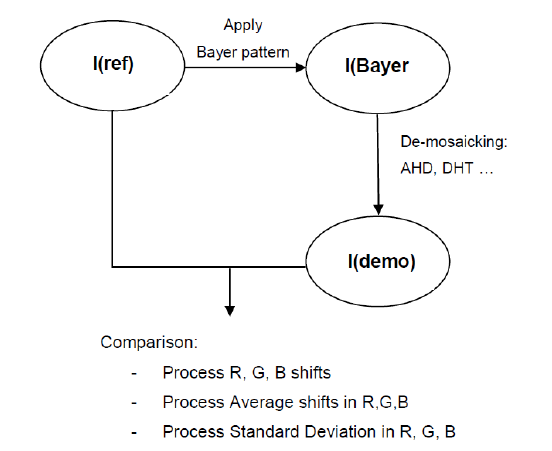
Figure 2: De-mosaicking test pipeline To evaluate how false, reconstructed colour is, for each channel, a comparison of the radiometric values of Red, Green and Blue channels in I(ref) and I(demo) is needed. Each channel in I(demo) is subtracted from the I(ref) and produces a Red, a Green and a Blue map of differences in float values. These maps are exported as float files and are analysed to extract statistics (Table 2&3, Figures 8&9) which will quantify false colours.